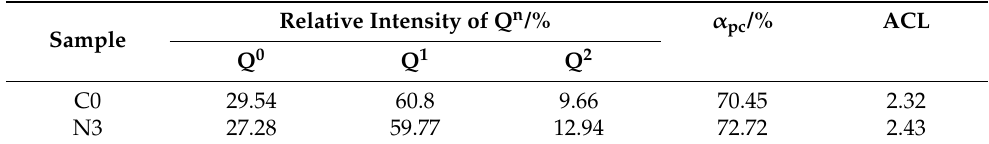
Figure 18. The deconvolution of 29 Si NMR spectrum of ( A ) C0 and ( B ) N3 at 28 days. Table 6. Quantitative analysis results of 29 Si NMR spectra.